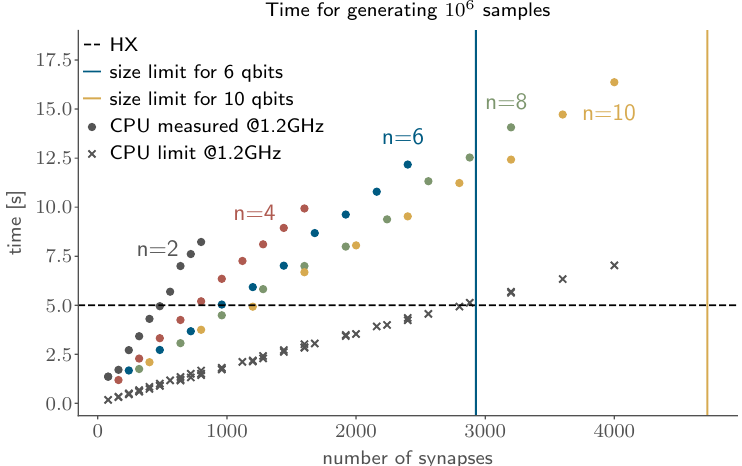
Figure 6: Measured (dots) and estimated (crosses) sampling times for the generation of a million samples, for different quantum system size ( N = 2, 4, 6, 8, 10 spins, colours) and hidden layer sizes ( M = 20, 40, 60, 80, 100, 120, 140, 160, 180, 200) on a Intel Xeon E5-2630v4 compared to the constant runtime of the BrainScaleS- 2 system (horizontal line). The software time estimation assumes one FLOP per clock cycle and one FLOP required per synaptic interaction, bias and state assignment (see text). The number of neurons on BrainScaleS-2 is limited to ( 2 N ) + M < 256 which limits the implementable system size (vertical lines, for 6 spins and 244 hidden neurons and 10 spins and 236 hidden